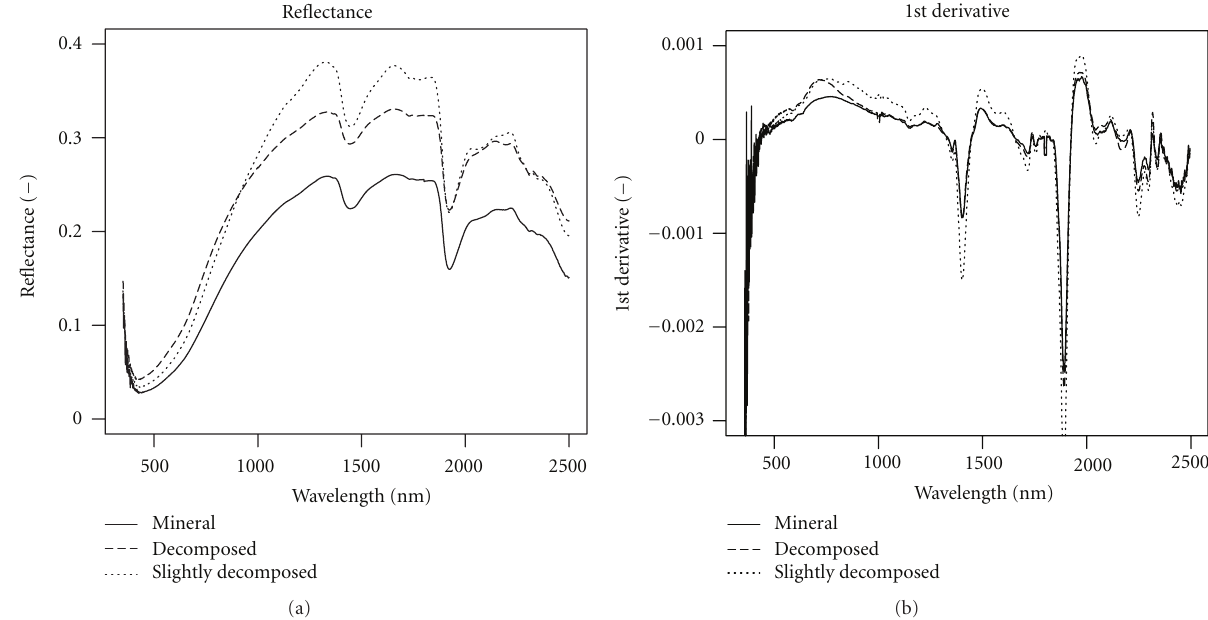
Figure 4: Spectral signatures of three horizons sampled at the same geographic location. The left graph shows the reflectance spectra, the right figure shows the first derivative of the reflectance